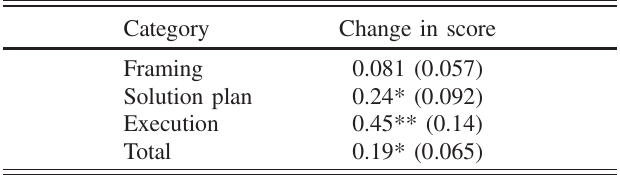
TABLE III. Change in framing, execution, planning, and total score on homework problem from week 2 to week